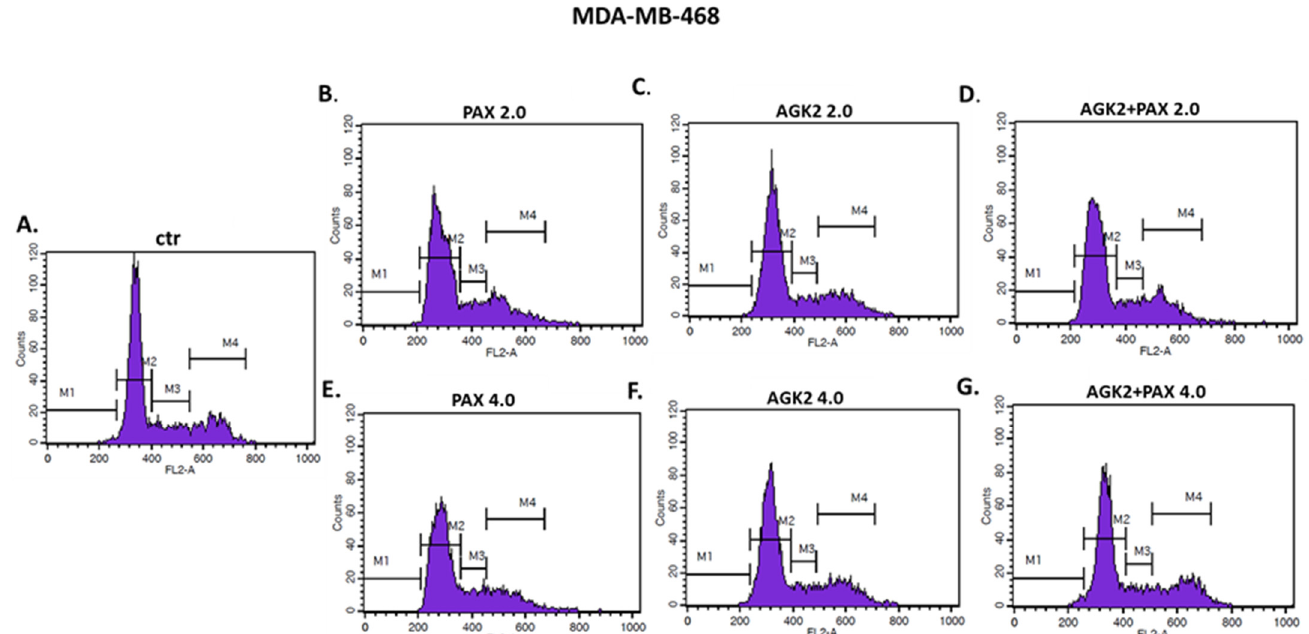
Figure 19. Representative histograms from the flow cytometry analysis of the MDA-MB-468 TNBC cells after a 48 h incubation with a medium (ctr) ( A ), paclitaxel (PAX) ( B , E ), AGK2 ( C , F ) and PAX + AGK2 ( D , G ) (2.0 = IC 50 + IC 50 , 4.0 = 2IC 50 + 2IC 50 ). M1—G0 (pre-G1) phase; M2—G1 phase; M3—S phase; M4—G2 phase.